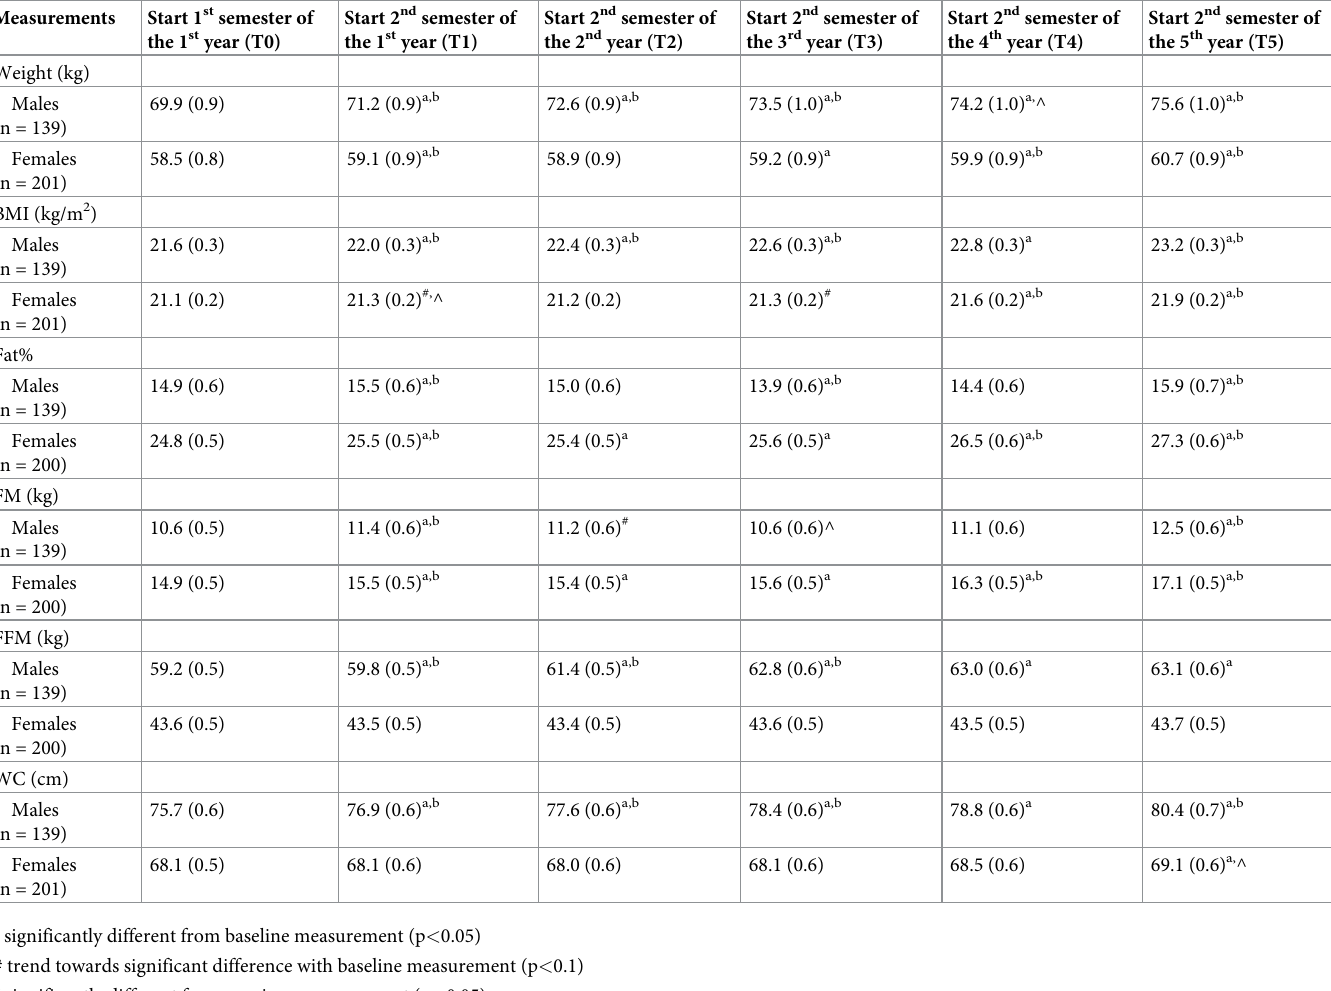
Table 1. Anthropometric mean estimates (SE) from freshman through senior year of university.